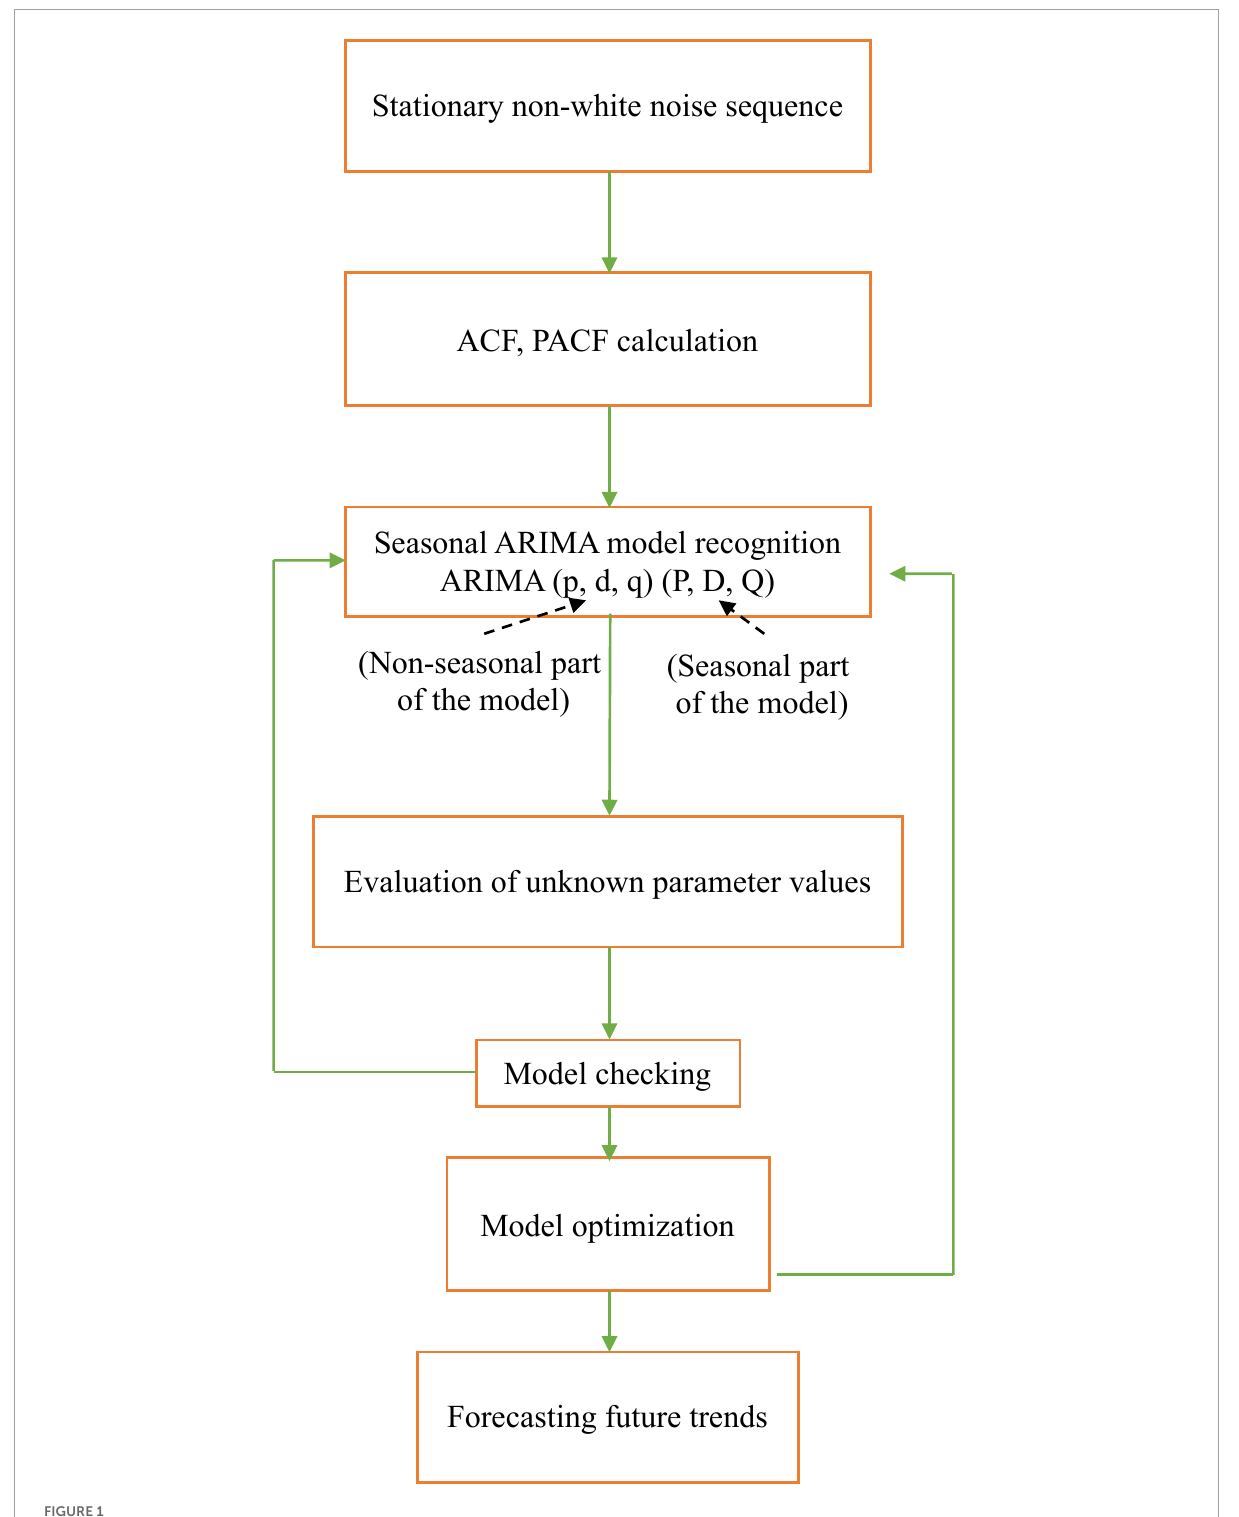
FIGURE1 Flow chart of seasonal ARIMA model steps. Agricultural chemical pesticides forecasting in China was performed using seasonal ARIMA (p,d,q) × (P,D,Q)S model with p = nonseasonal autoregressive (AR) order, d = nonseasonal differencing, q = nonseasonal moving average (MA) order, P = seasonal AR order, D = seasonal differencing, Q = seasonal MA order, and S = time span of repeating seasonal pattern (Abdul-Aziz et al., 2013). ARIMA, autoregressive integrated moving average; ACF, autocorrelation function; PACF, partial autocorrelation.